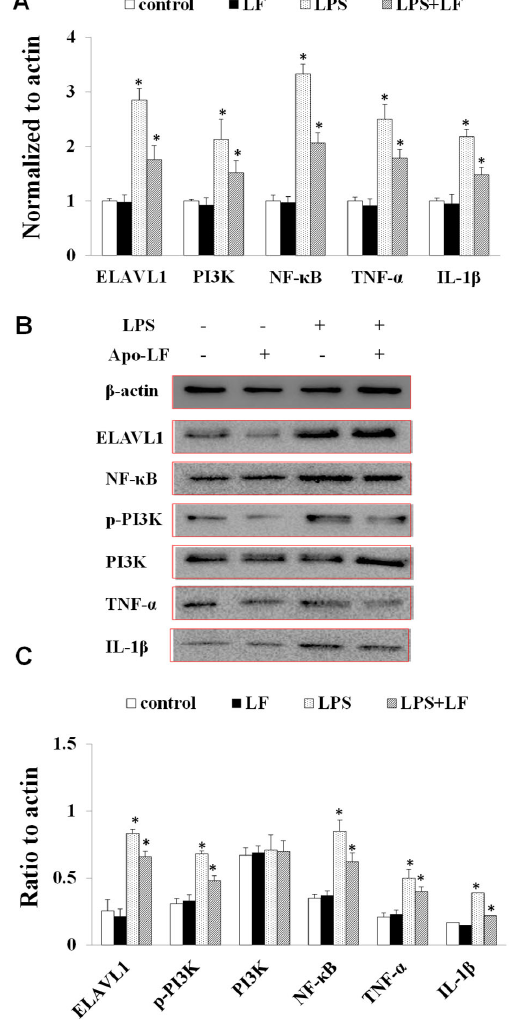
Figure 5. The expression levels of immune-related factors in mouse blood treated by Apo-LF. ( A ) The mRNA expression levels of ELAVL1, PI3K, NF- κ B, TNF- α and IL-1 β in the blood of mice; ( B ) The protein expression levels of ELAVL1, p-PI3K, PI3K, NF– κ B, TNF- α and IL-1 β in the blood of mice. n = 3 mice per group. Data represent mean ± SD. * p < 0.05 by Student’s t -test. LF in this figure represents Apo-LF